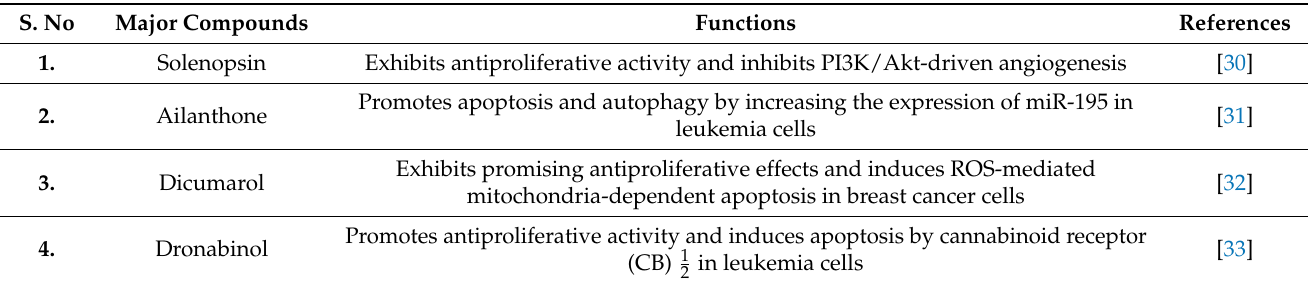
Table 2. Major compounds of Tamarix articulata exhibiting antitumor